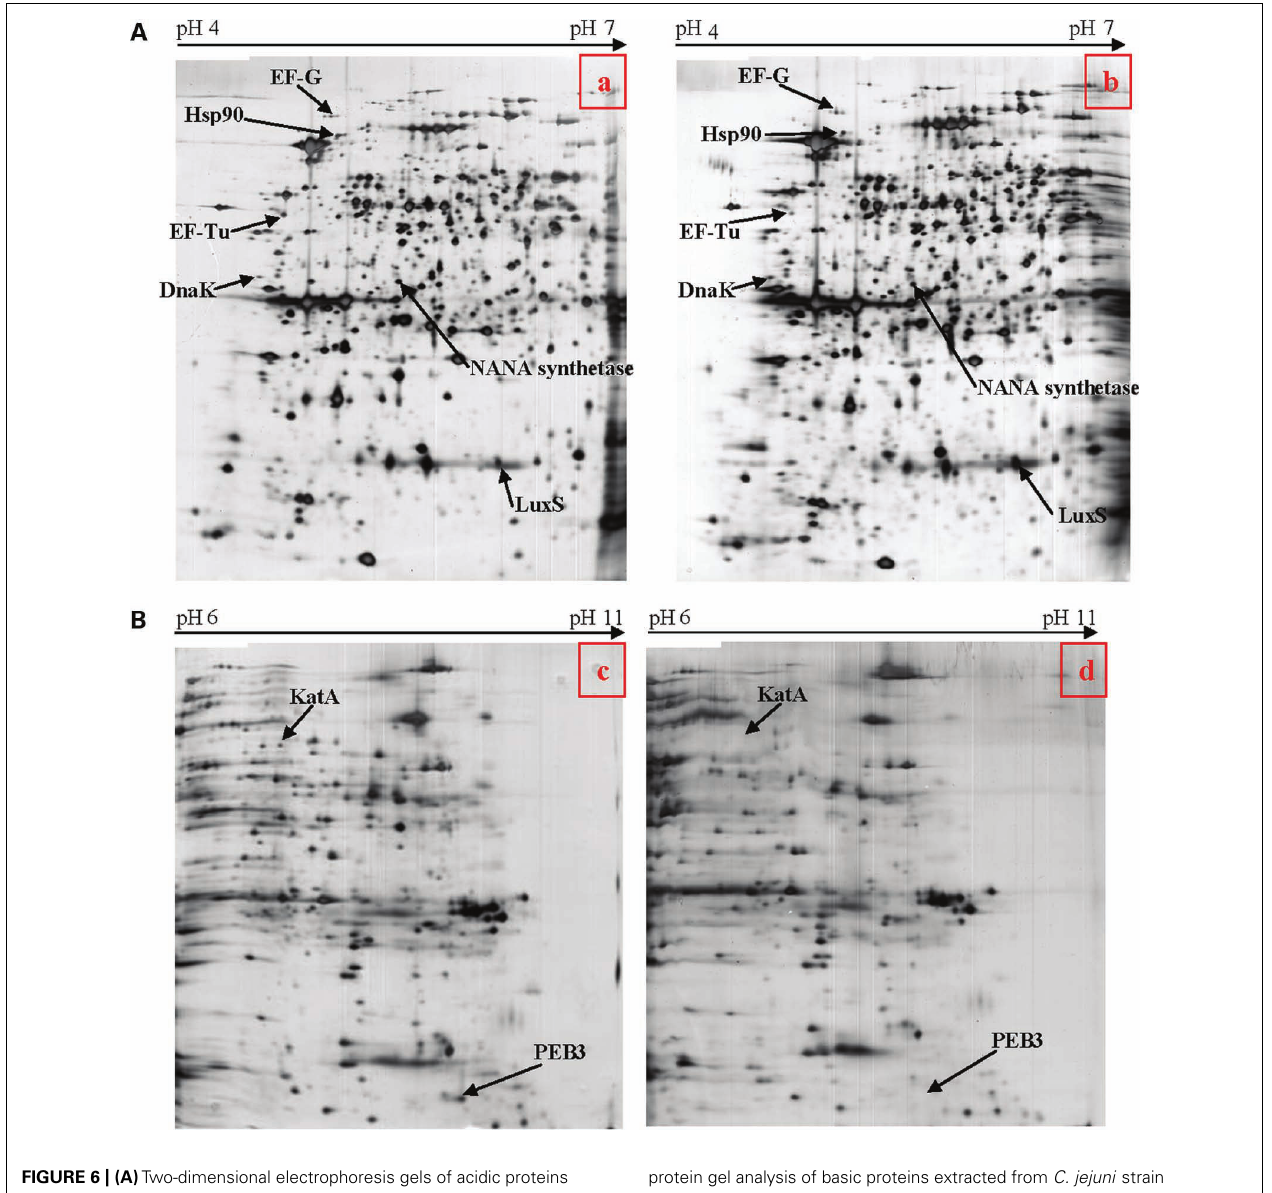
FIGURE 6 | (A) Two-dimensional electrophoresis gels of acidic proteins extracted from C. jejuni strain 81-176 (a) and the pnp mutant (b) derived from this strain. Proteins were extracted from bacteria cultivated in BHI at 42 ◦ C collected when OD 600 reached 0.2. (B) Two-dimensional